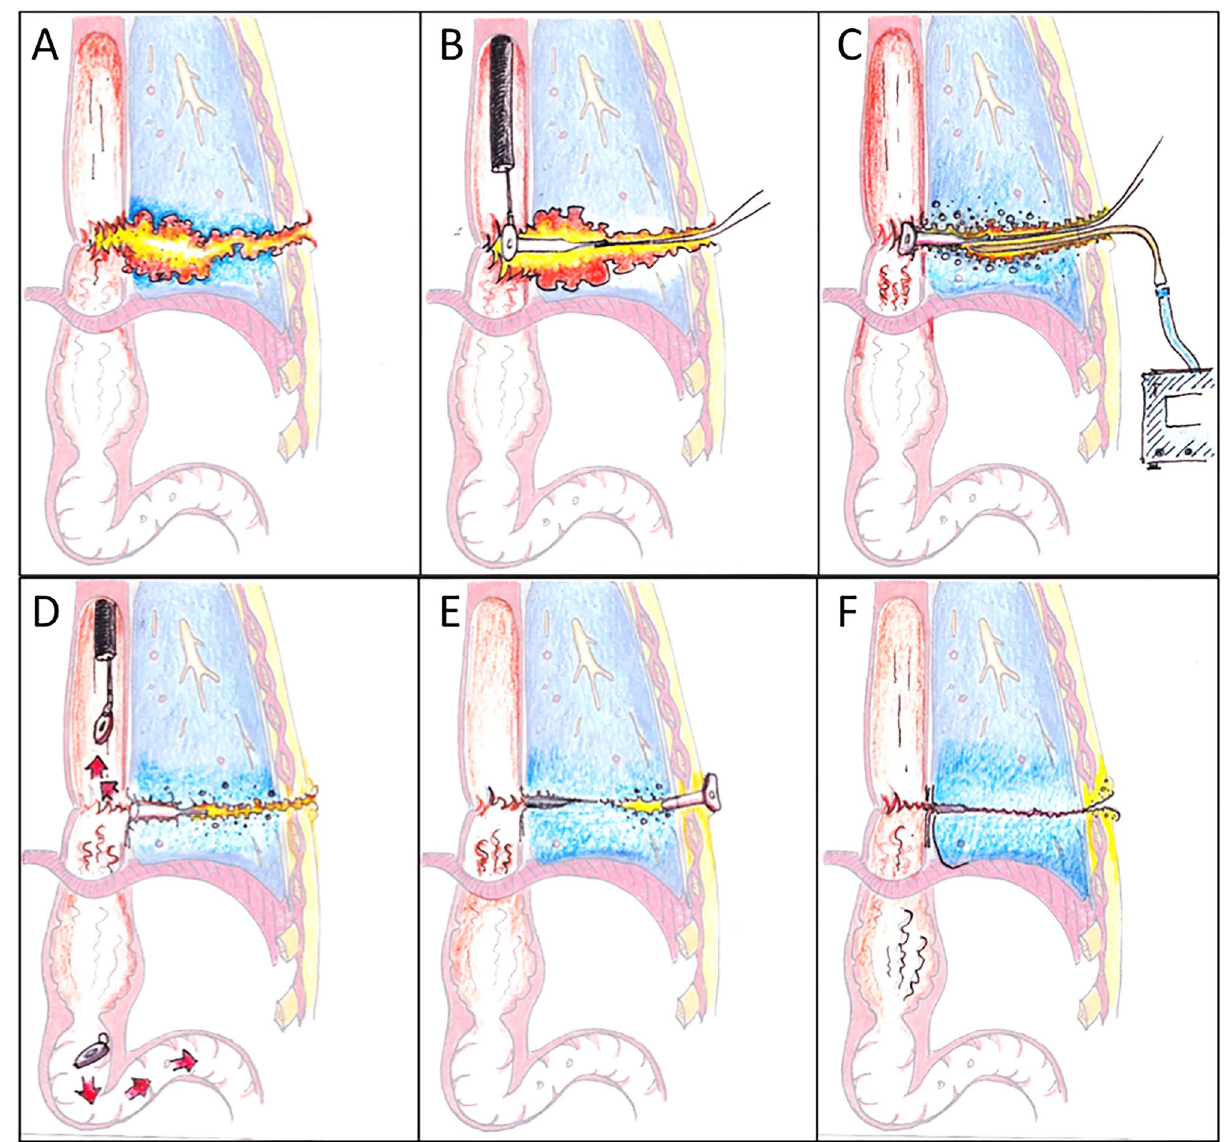
Figure 1. ( A ) Anastomotic leak with a percutaneous fistula. ( B ) Endoscopic plug implantation into the fistula orifice. ( C ) Percutaneous and fistuloscopically placed under pressure therapy with open-pore film drainage. ( D ) Separation of the plug plate and continuation of the vacuum therapy until closure of the orifice. ( E ) Avoidance of premature skin closure by implantation of a shortened und inverted PEG tube. ( F ) Removal of the PEG and final